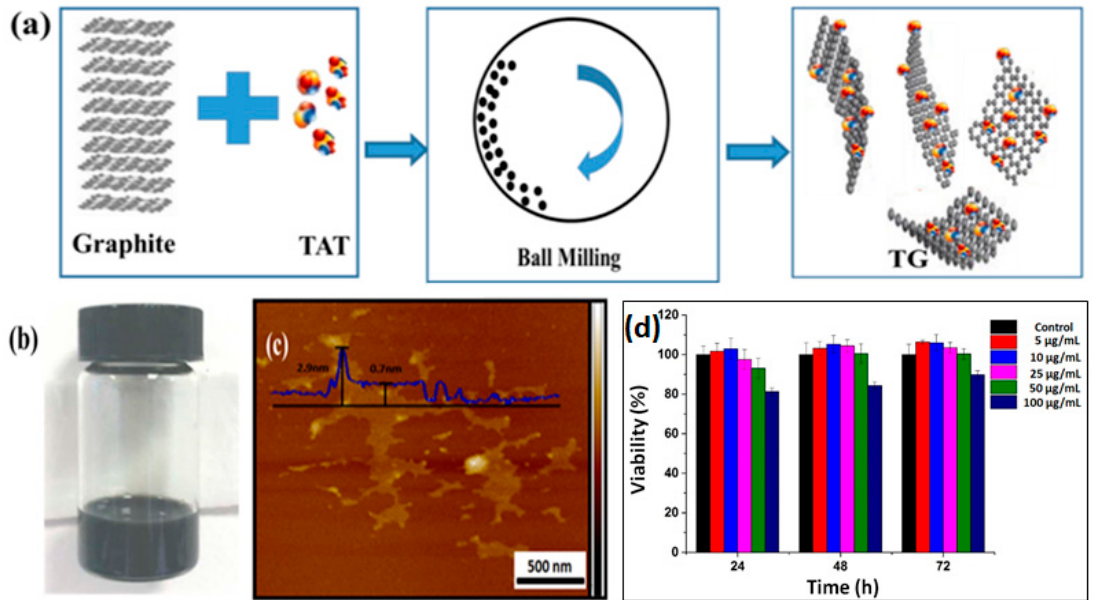
Figure 1. ( a ) A schematic synthesis of trans-activating transcriptional activator (TAT) Figure1. ( a )Aschematicsynthesisoftrans-activatingtranscriptionalactivator(TAT)peptide-functionalized peptide-functionalized graphene (TG) via the ball-milling method, ( b ) digital image of the TG well graphene (TG) via the ball-milling method, ( b ) digital image of the TG well dispersed in deionized water, dispersed in deionized water, ( c ) atomic force microscopy (AFM) micrograph of the as-prepared TG, ( c ) atomic force microscopy (AFM) micrograph of the as-prepared TG, and ( d ) the cell viability of